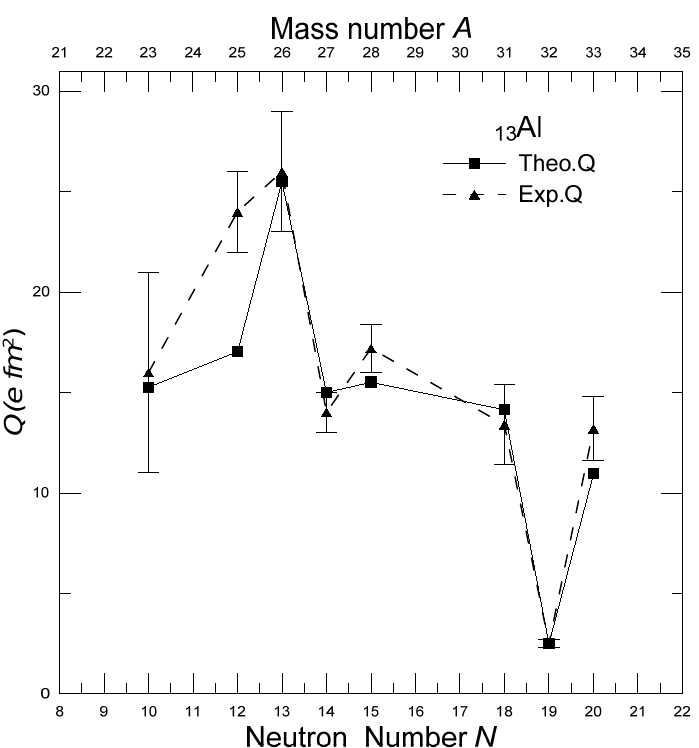
Fig. 1: Experimental [18] and theoretical quadrupole moments versus neutron number for Al isotopes.